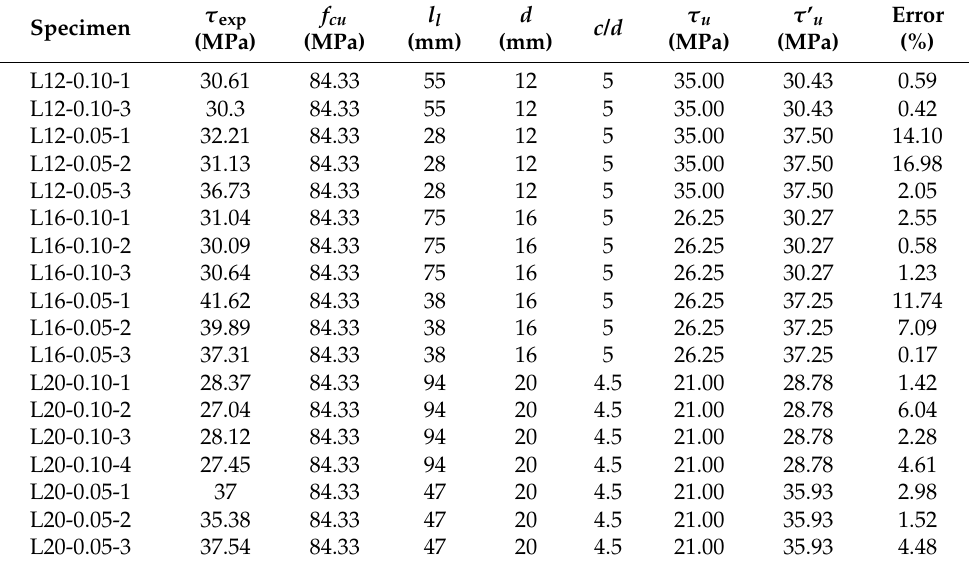
Table 5. Comparison of the ultimate bond strength between theoretical and semi-empirical values and test